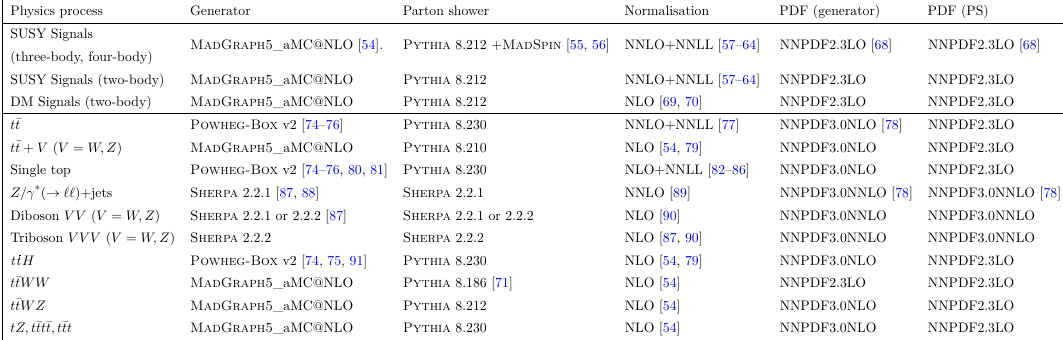
used to normalise the event yield, and s